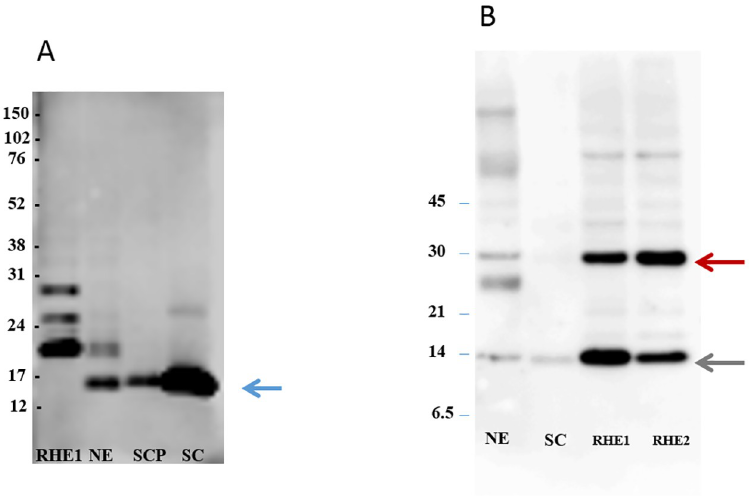
Fig 4. FLG2Nter is present in the stratum corneum of human skin in vivo . A) Western blot analysis showing the detection of a 14 kDa band (blue arrow) representing the N-terminal domain of FLG2 in soluble protein extracts from the human stratum corneum and epidermis of normal skin. The contrast was enhanced from the original image (see supplementary information) to better visualize the bands. B) Western blot analysis showing the presence of SASPase 28 (red arrow) and the 14 kDa catalytic form of SASPase (green arrow) in epidermis of human skin and reconstructed skin. (RHE = reconstructed epidermal skin; NE = epidermis from normal skin; SCP = plantar stratum corneum; SC = stratum corneum (sampled by varnish stripping). Protein Molecular Weight markers are indicated on the left of each image.